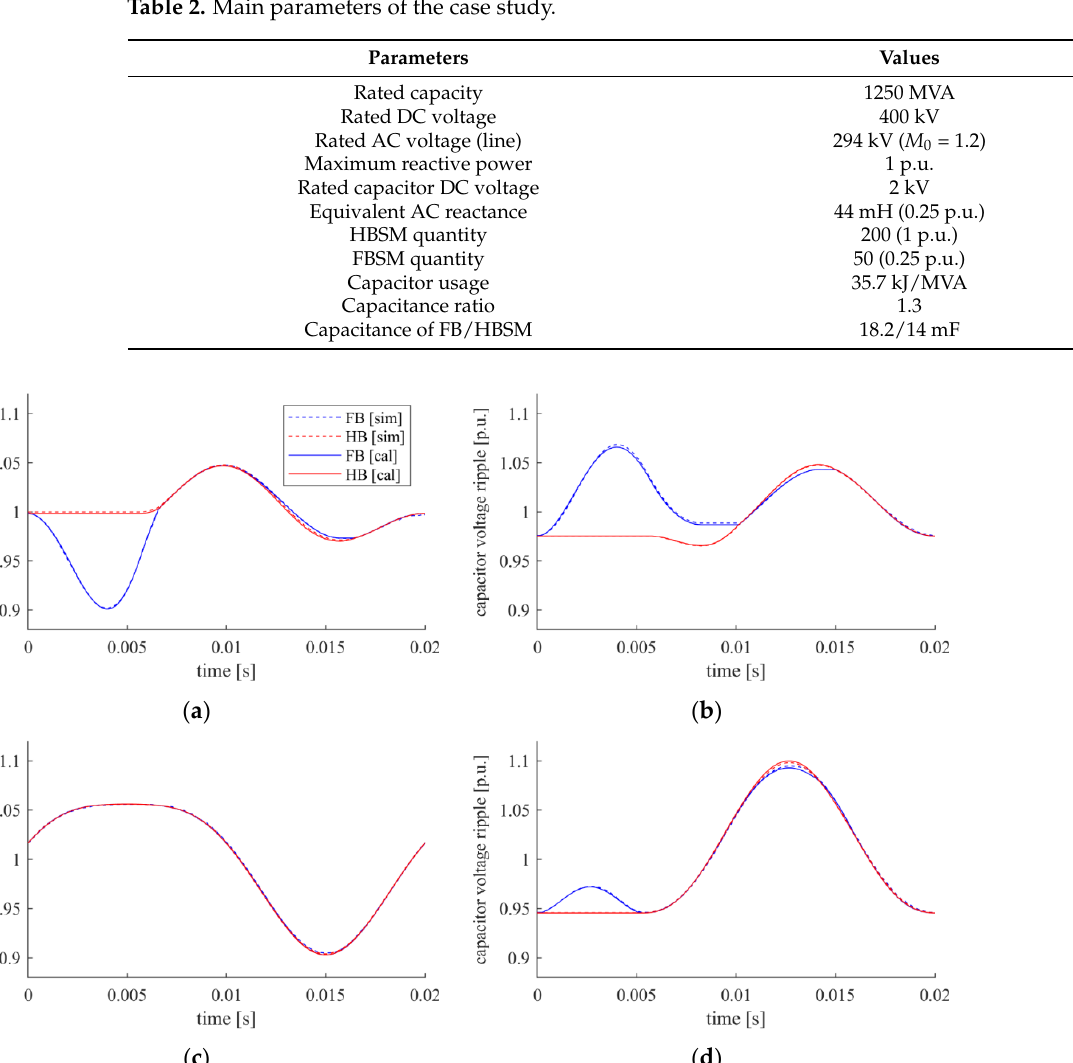
Figure 10. Simulation and calculation waveform of capacitor voltages in different operating points: ( a ) pure active output (inverting) ( φ = 0); ( b ) pure active input (rectifying) ( φ = π ); ( c ) pure inductive ϕ = 0); ( b ) pure active input (rectifying) ( ϕ = π ); ( c ) pure inductive reactive power ( φ = −π /2); ( d ) pure capacitive reactive power ( φ = π /2). ( a ) pure active output (inverting) ( reactive power ( ϕ = − π /2); ( d ) pure capacitive reactive power ( ϕ = π